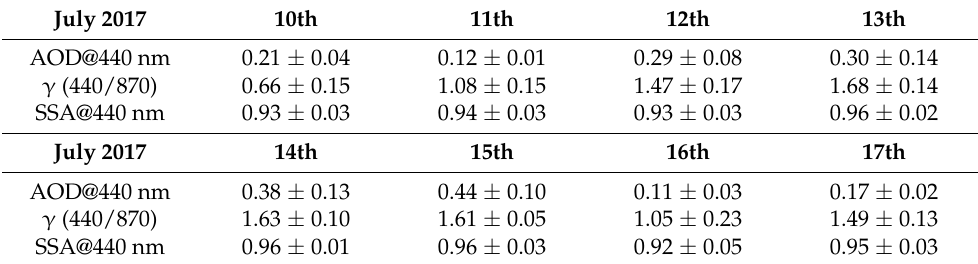
Table 2. Daily mean values of AOD, γ and SSA for period 10–17 July 2017.